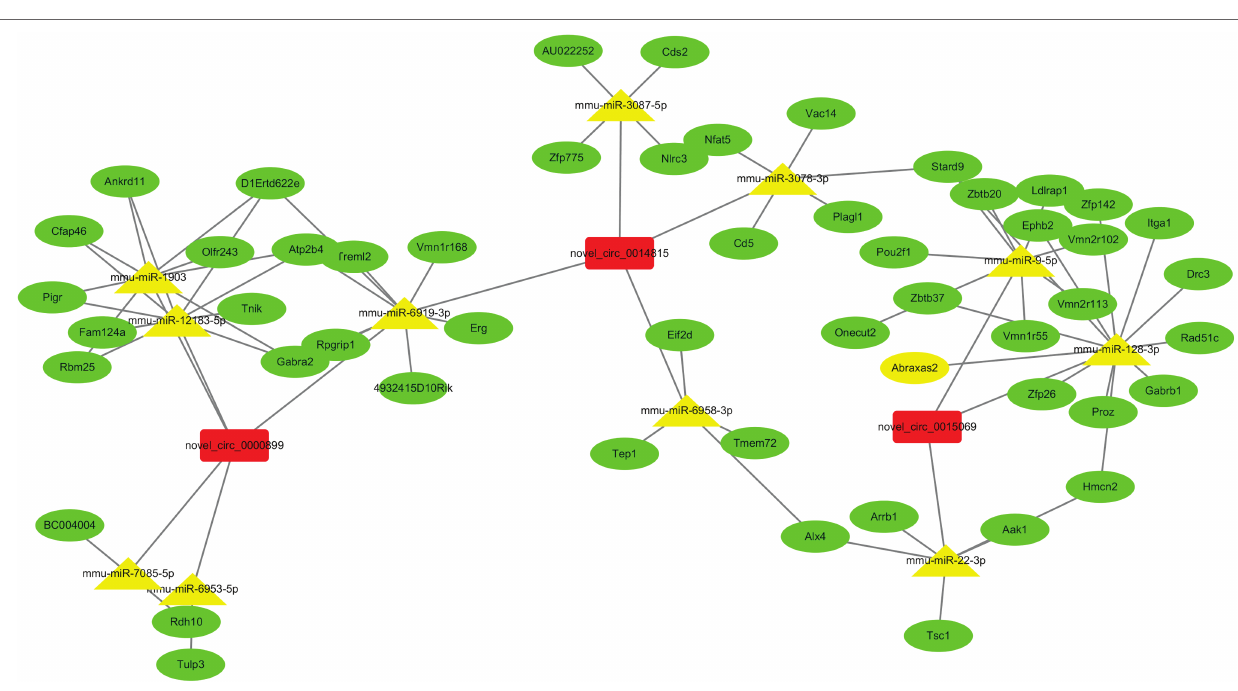
FIGURE 6 | The network of ceRNA (circRNA-miRNA-mRNA). The two upregulated circRNAs and one downregulated circRNA were annotated in detail according to the circRNA-miRNA-mRNA interaction information from Cytoscape. Based on the miRNA and mRNA prediction, we showed that the top 5 miRNAs may be regulated by two upregulated circRNAs, one downregulated circRNA, and the top 30 target genes of each miRNA. releases inflamed mediators, and causes an inflammatory response, ultimately resulting in lung injury (Curley et al., 2016; Chen et al.,